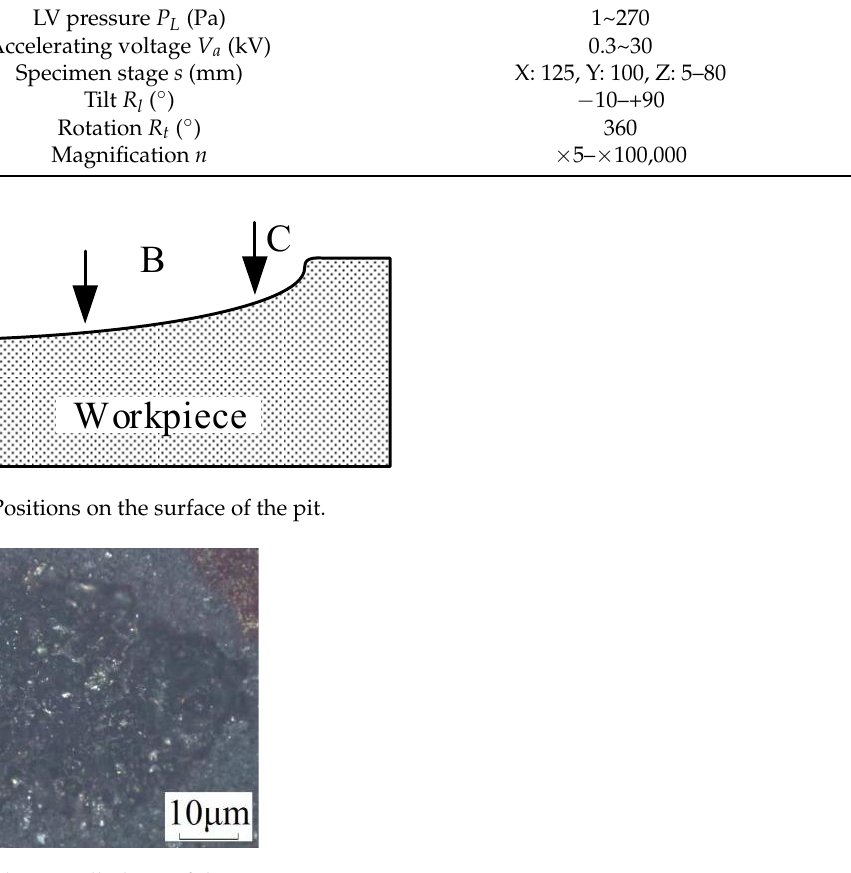
Figure 16. The overall photo of the pit. Table 3. The parameters of SEM.